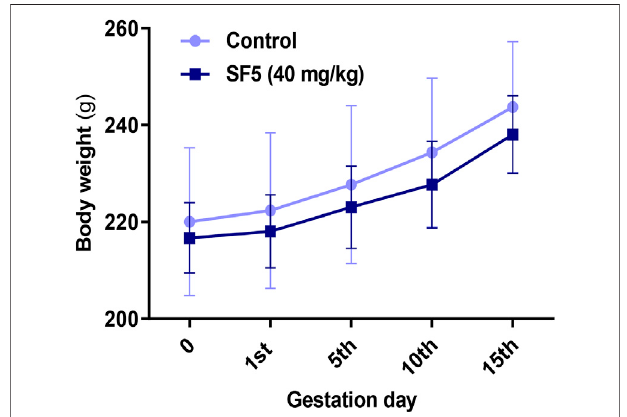
FIGURE 9 | Effect of SF5 on body weights of rats in the developmental toxicity study.